Question: How would you classify this visualization?
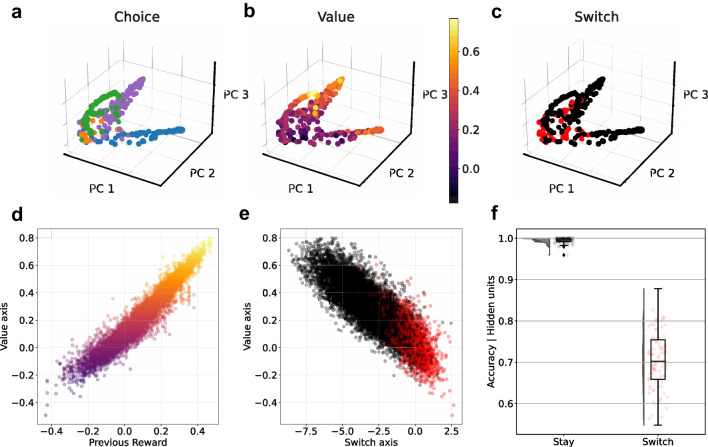
Answer: scatter